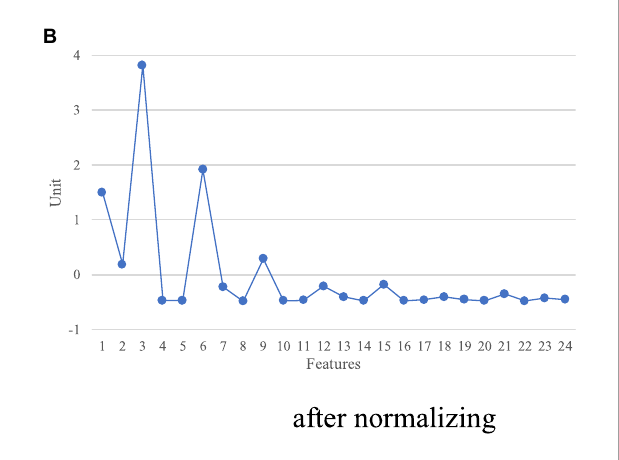
FIGURE7 A feature vector with a size of 24 (A,B) before and after